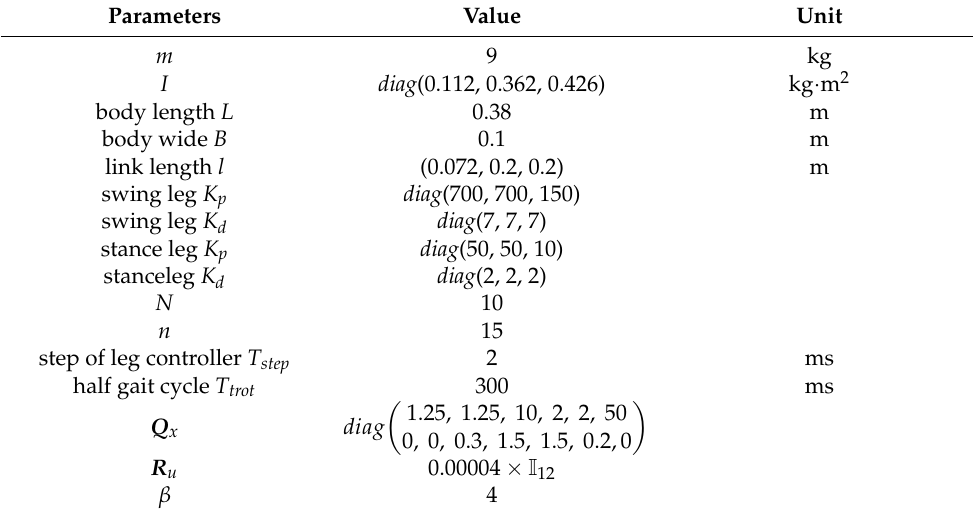
Table 1. Model parameters and simulation parameters.